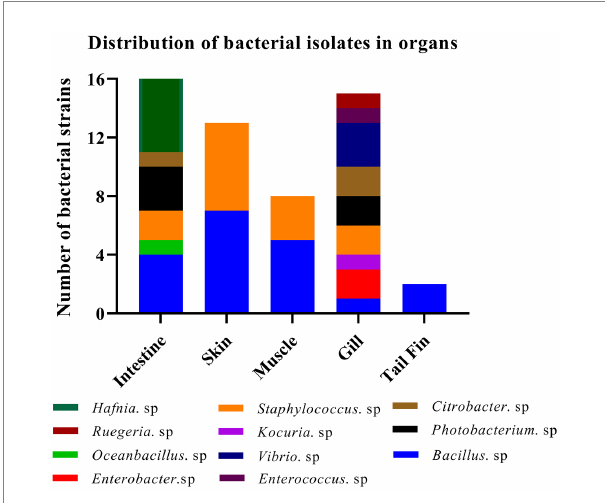
FIGURE 1 Identification of strains of 11 genera among 64 isolates from different organs of the diseased large yellow